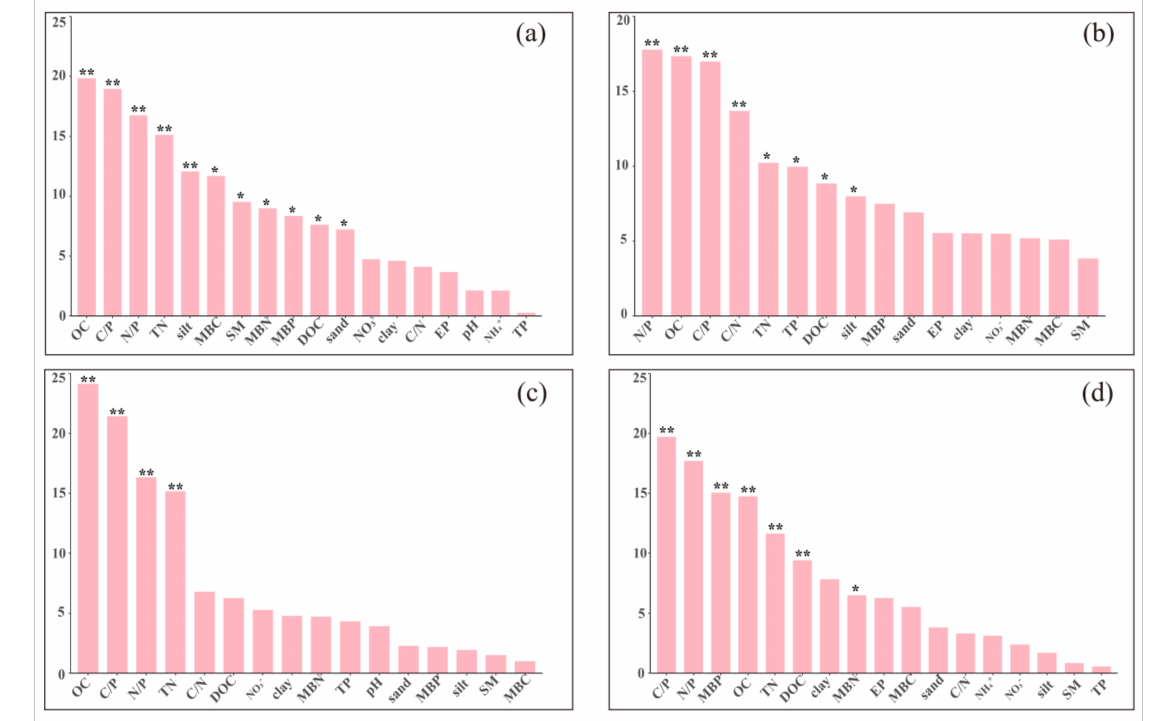
Figure 5. The Random Forest model (RF) was used to determine the key factors affecting ( a ) soil extracellular enzymatic activity, ( b ) soil microbial N limitation, ( c ) P limitation, and ( d ) Threshold elemental ratio (TER L ). SM: soil moisture; OC: soil organic carbon; TN: total nitrogen; TP: total phosphorus; DOC: dissolved organic carbon; EP: soil available phosphorus; NO 3 − : nitrate nitrogen; NH 4+ : ammonia nitrogen. **, * mean the significant differences at p < 0.01 and p < 0.05, respectively. Table 2. Simple term effects and forward selection of environmental variables on microbial nutrient limitations from the redundancy analysis (RDA). Variable Simple Term Effect Forward Selection Contributions % Explains